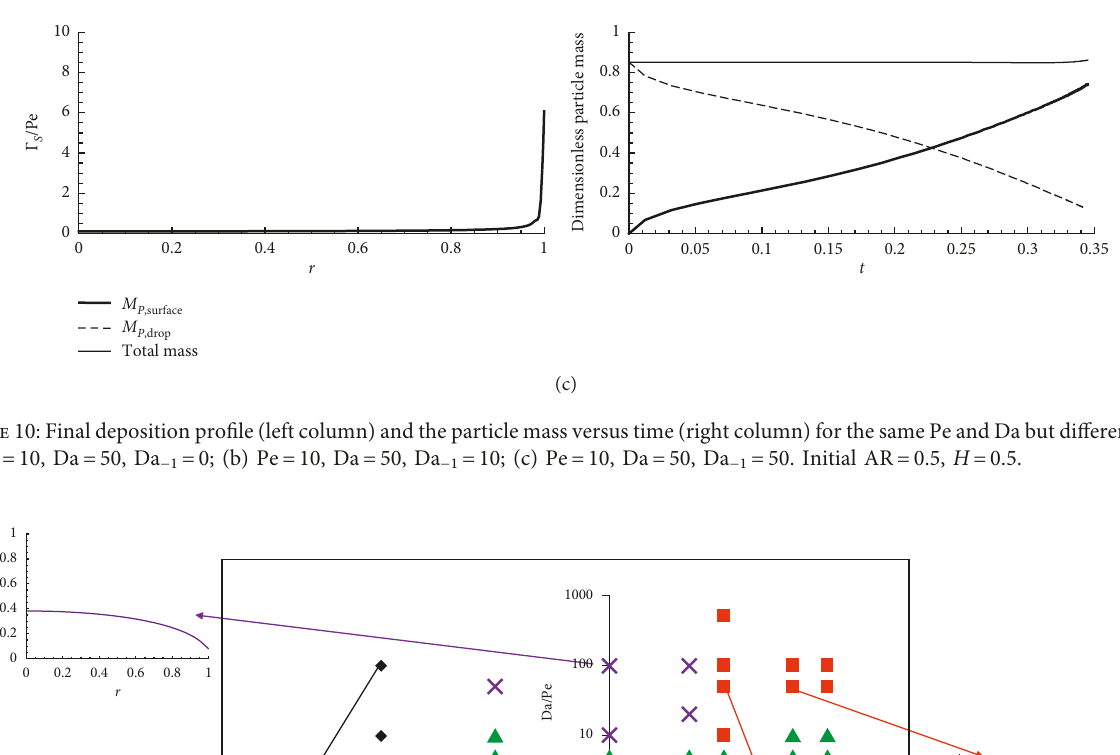
0 0.2 0.4 0.6 0.8